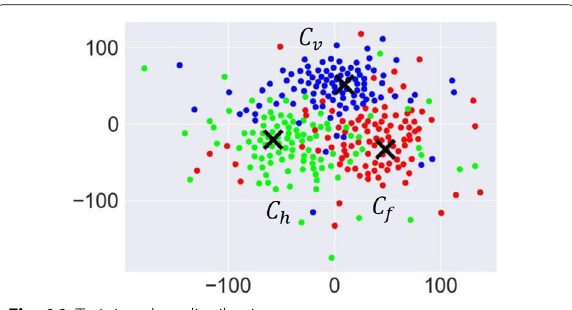
Fig. 16 Training data